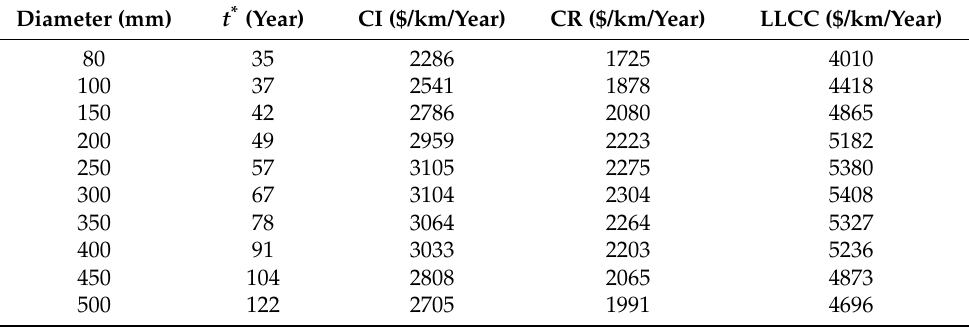
Table 2. LLCC (least life cycle cost) and corresponding replacement age ( t ∗ ) for different diameters. Diameter (mm) t *